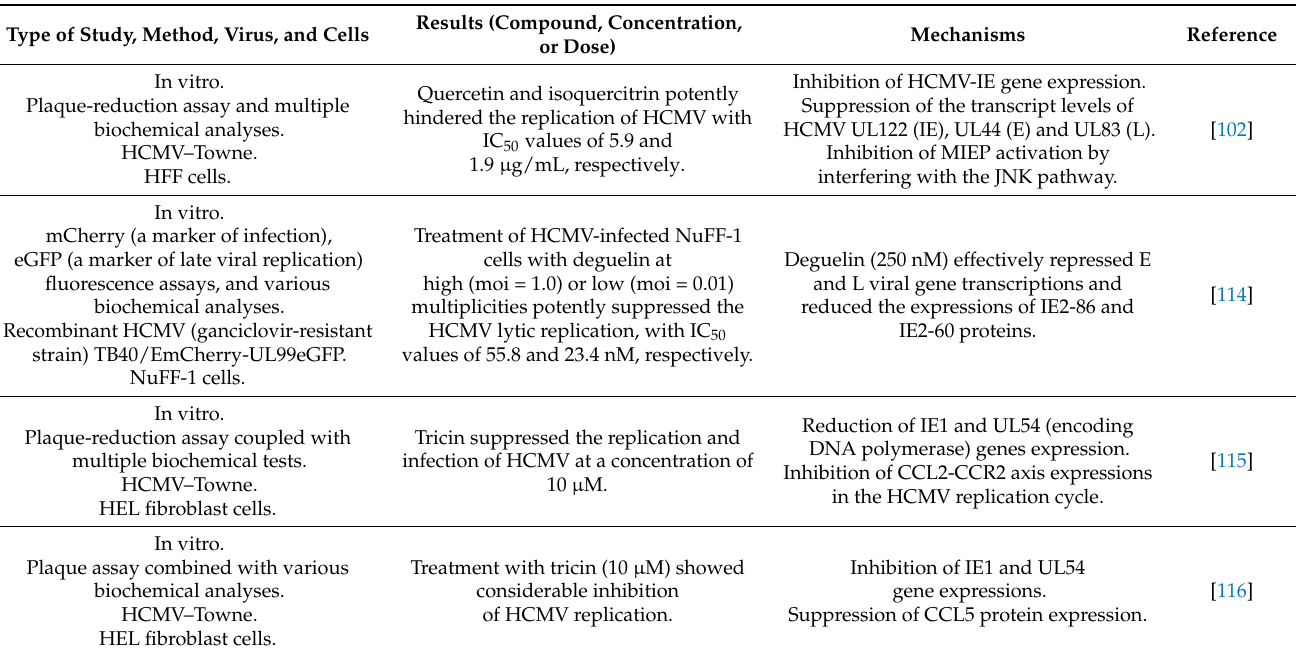
Table 2. Antiviral properties of flavonoids against human cytomegalovirus with various mechanisms of